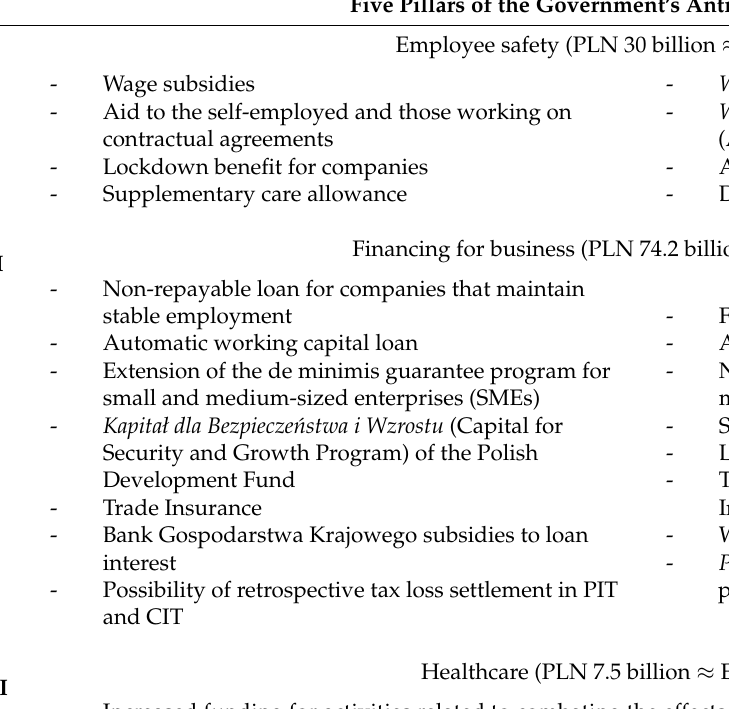
Table 1. The scope of funding under the Anti-Crisis Shield program. Five Pillars of the Government’s Anti-Crisis